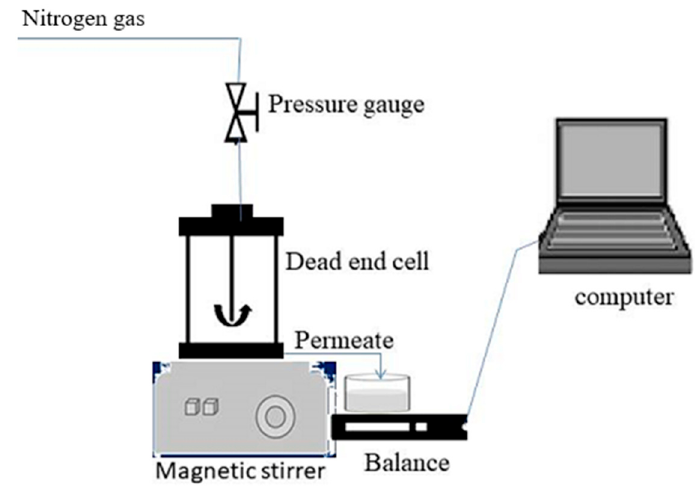
Figure 9. Graphical illustration of the dead-end filtration setup.